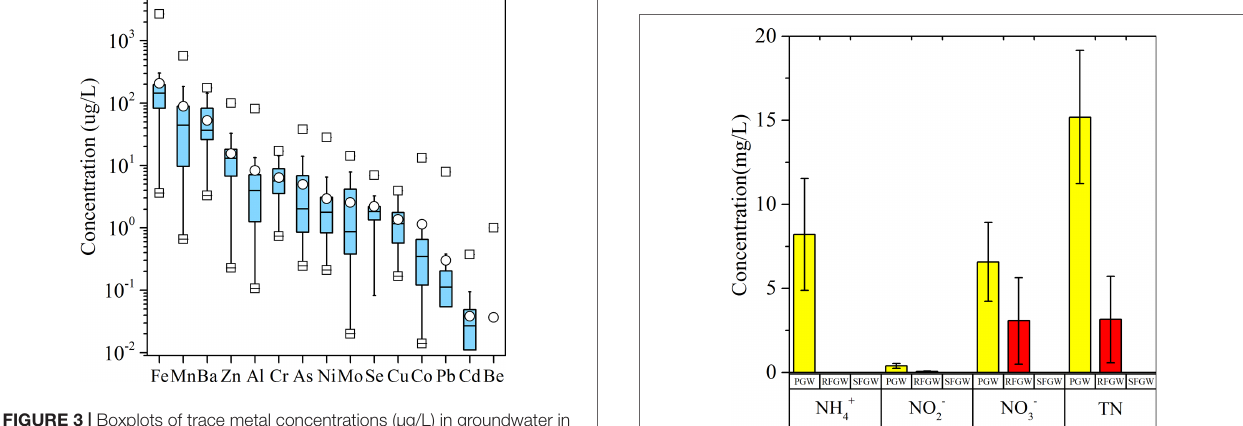
FIGURE 3 | Boxplots of trace metal concentrations (μg/L) in groundwater in the study area. Logarithmic coordinates are used for the y-axis due to the large variation in concentration